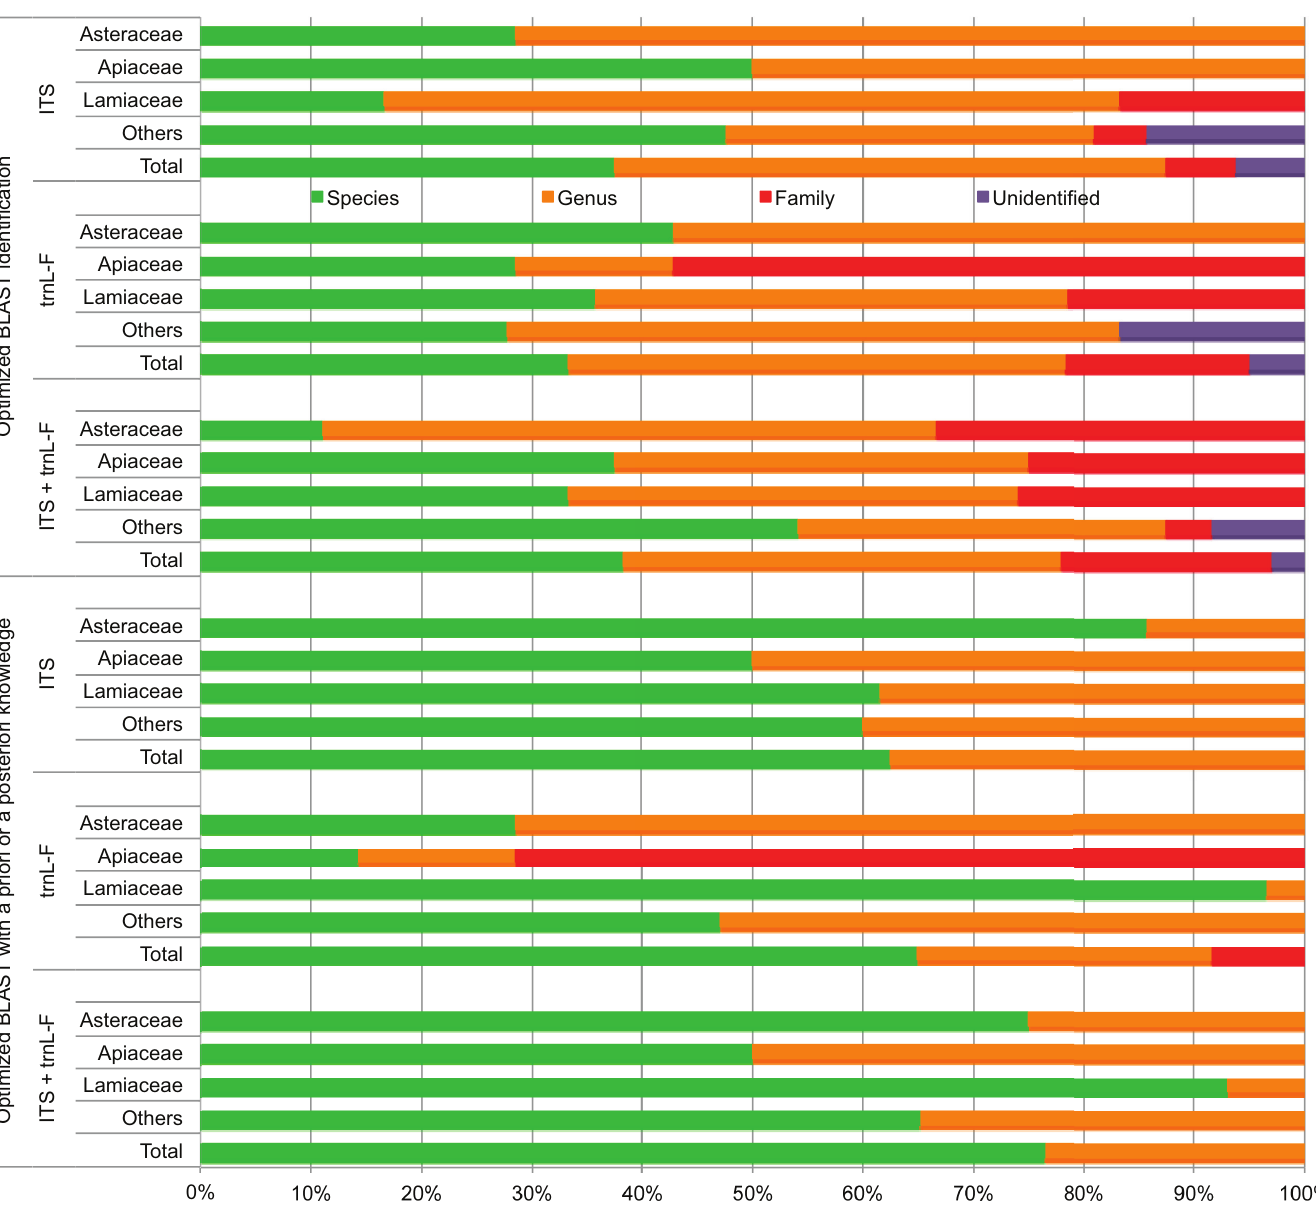
Fig 1. Comparison of identification success rates amongdifferent plant families 1) when relyingon sequencematchingalone, and 2) when a priori and a posteriori informationis incorporatedin the identification process for each of the two markers separately and when they are combined.